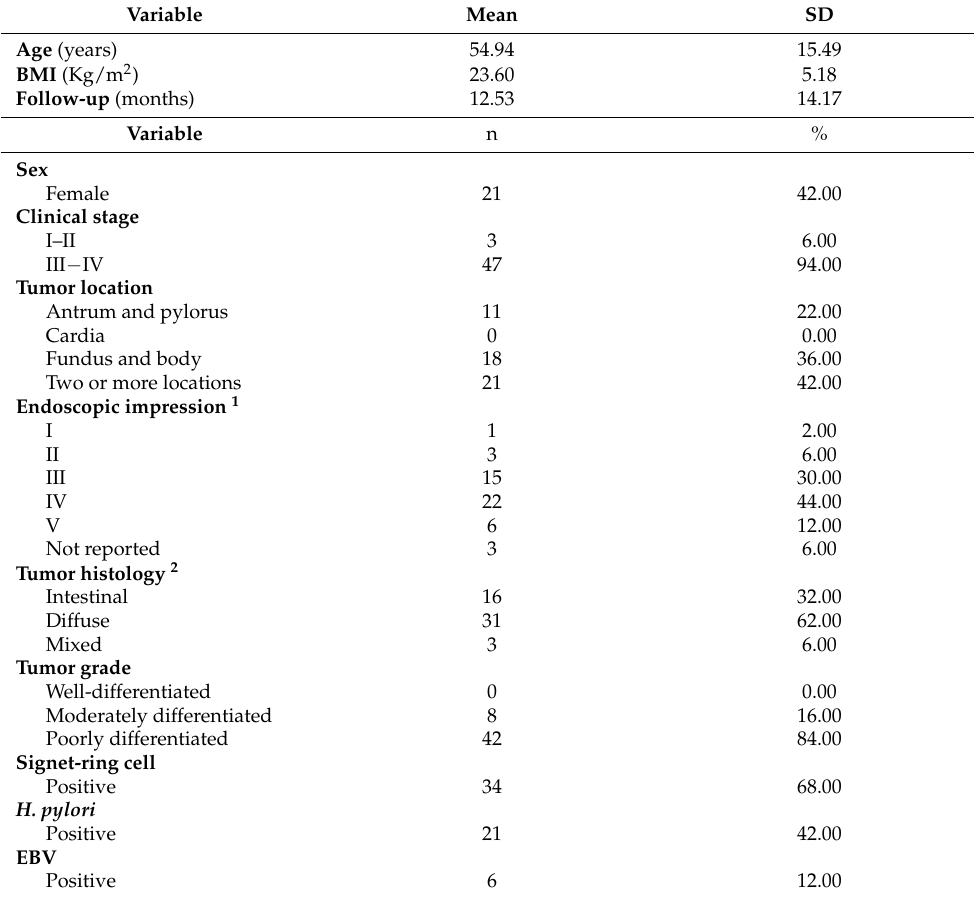
Table 1. The clinical and pathological characteristics of patients treated at The Instituto Nacional de Cancerolog í a between January 2019 and January 2020 (N =